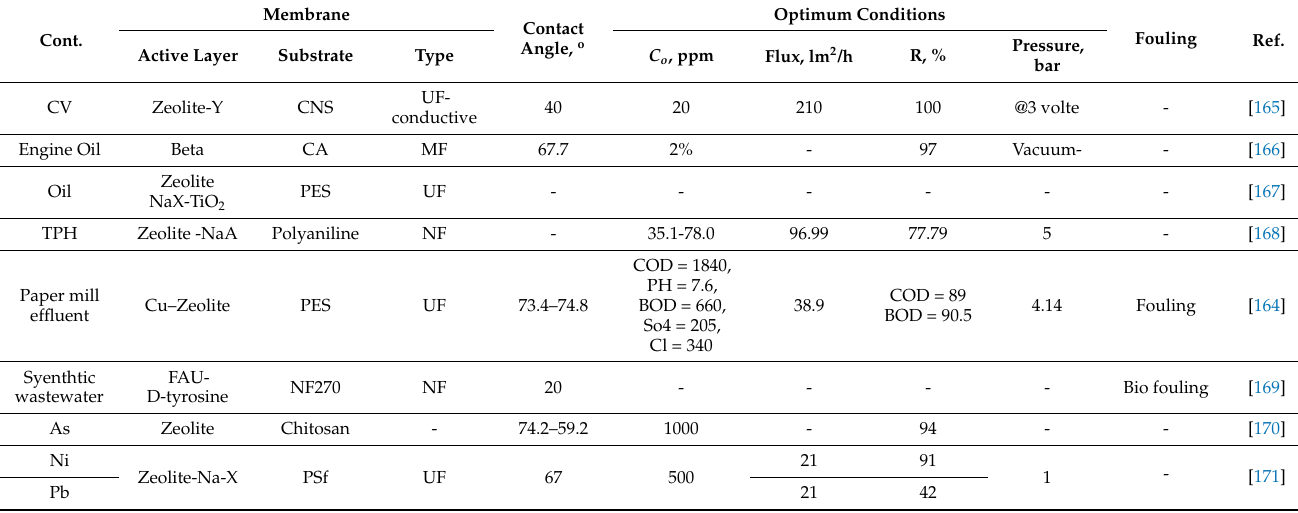
Table 9. Application of nano-zeolite in membrane